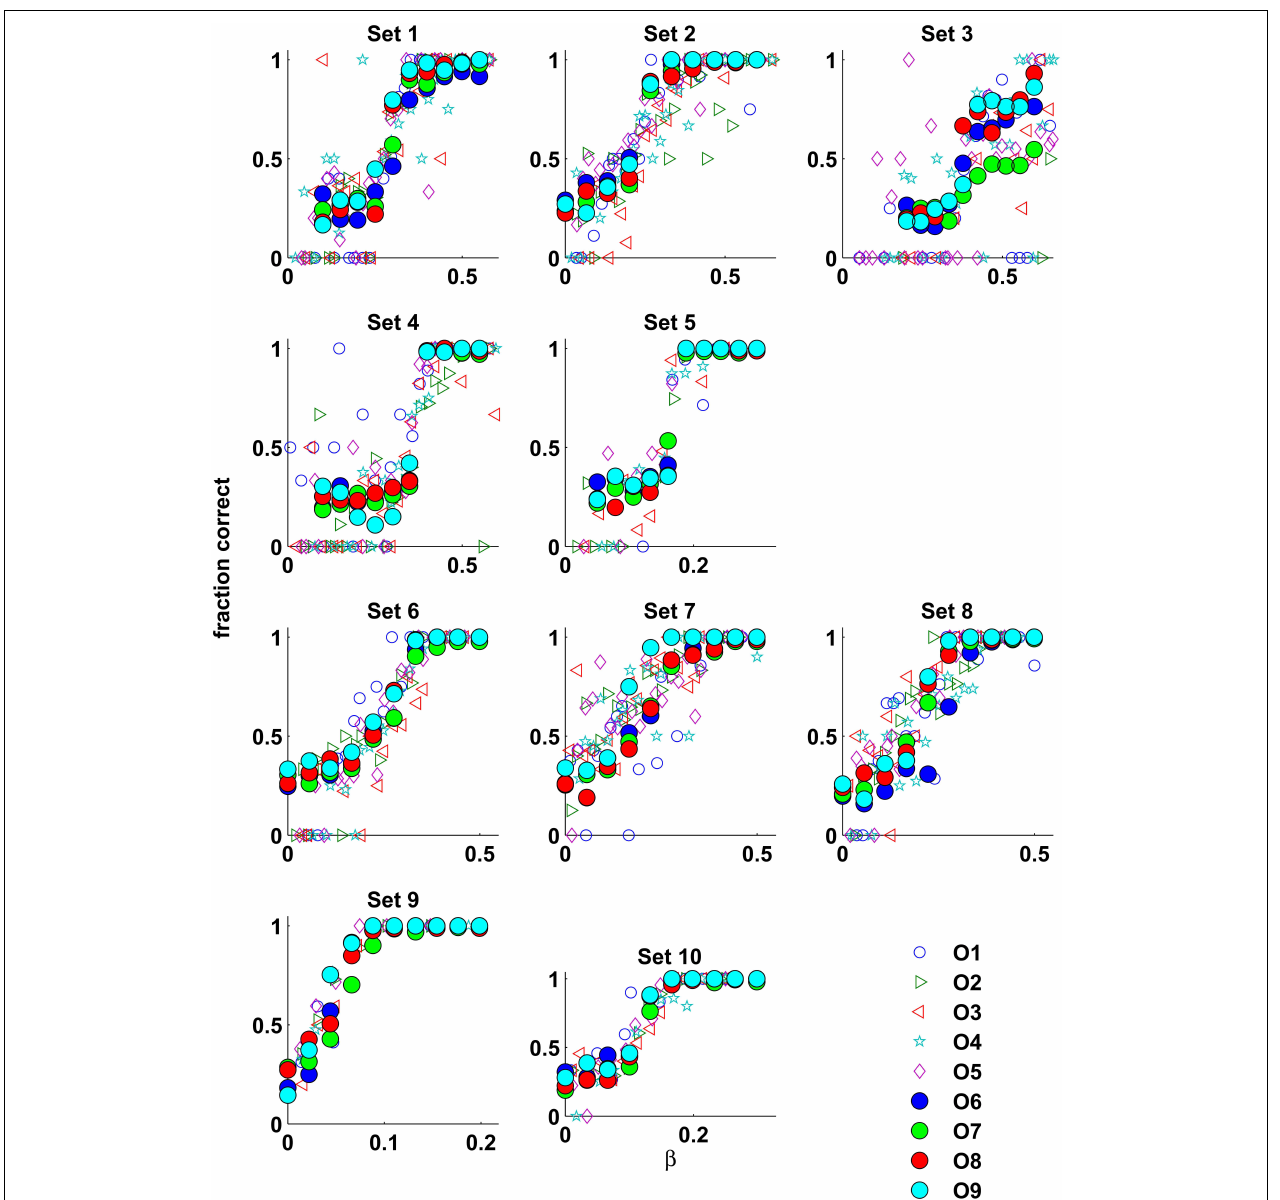
stimulus, the performances of the human observers in both experiments are in good agreement. Moreover, in Experiment 2 there is almost a perfect match between the observers’ performances.